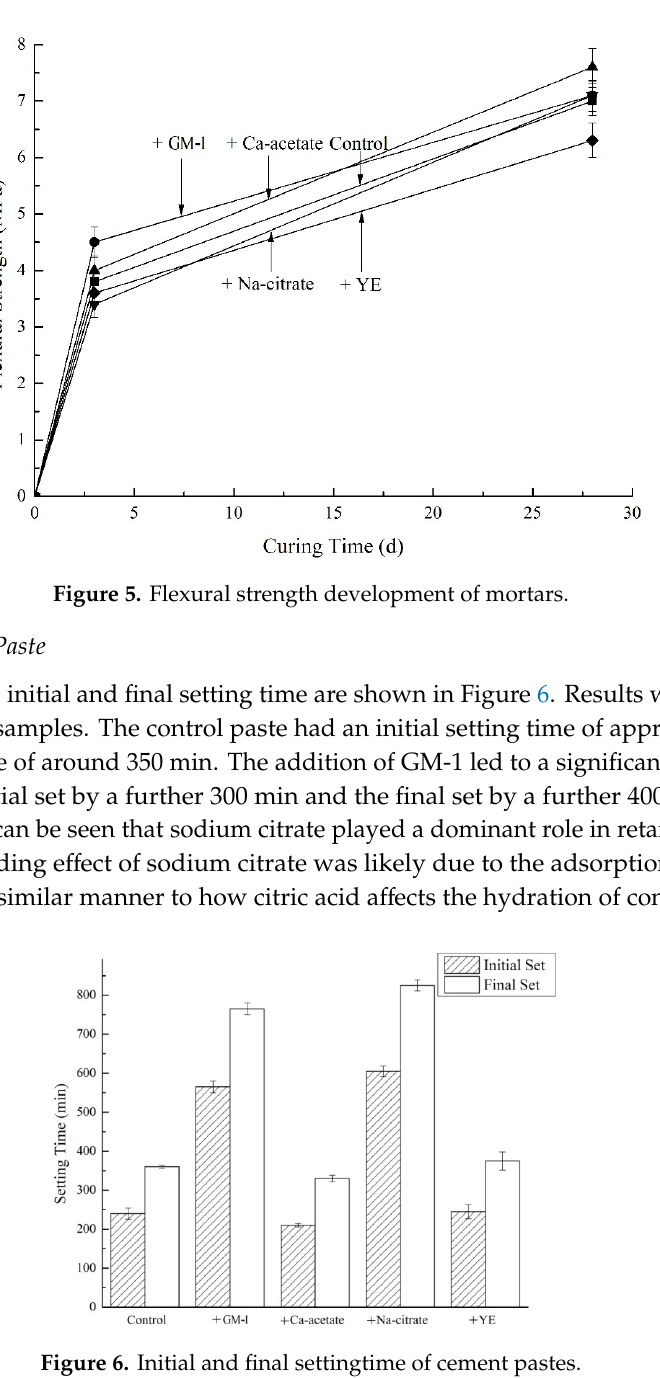
Figure 4. Compressive strength development of mortars.